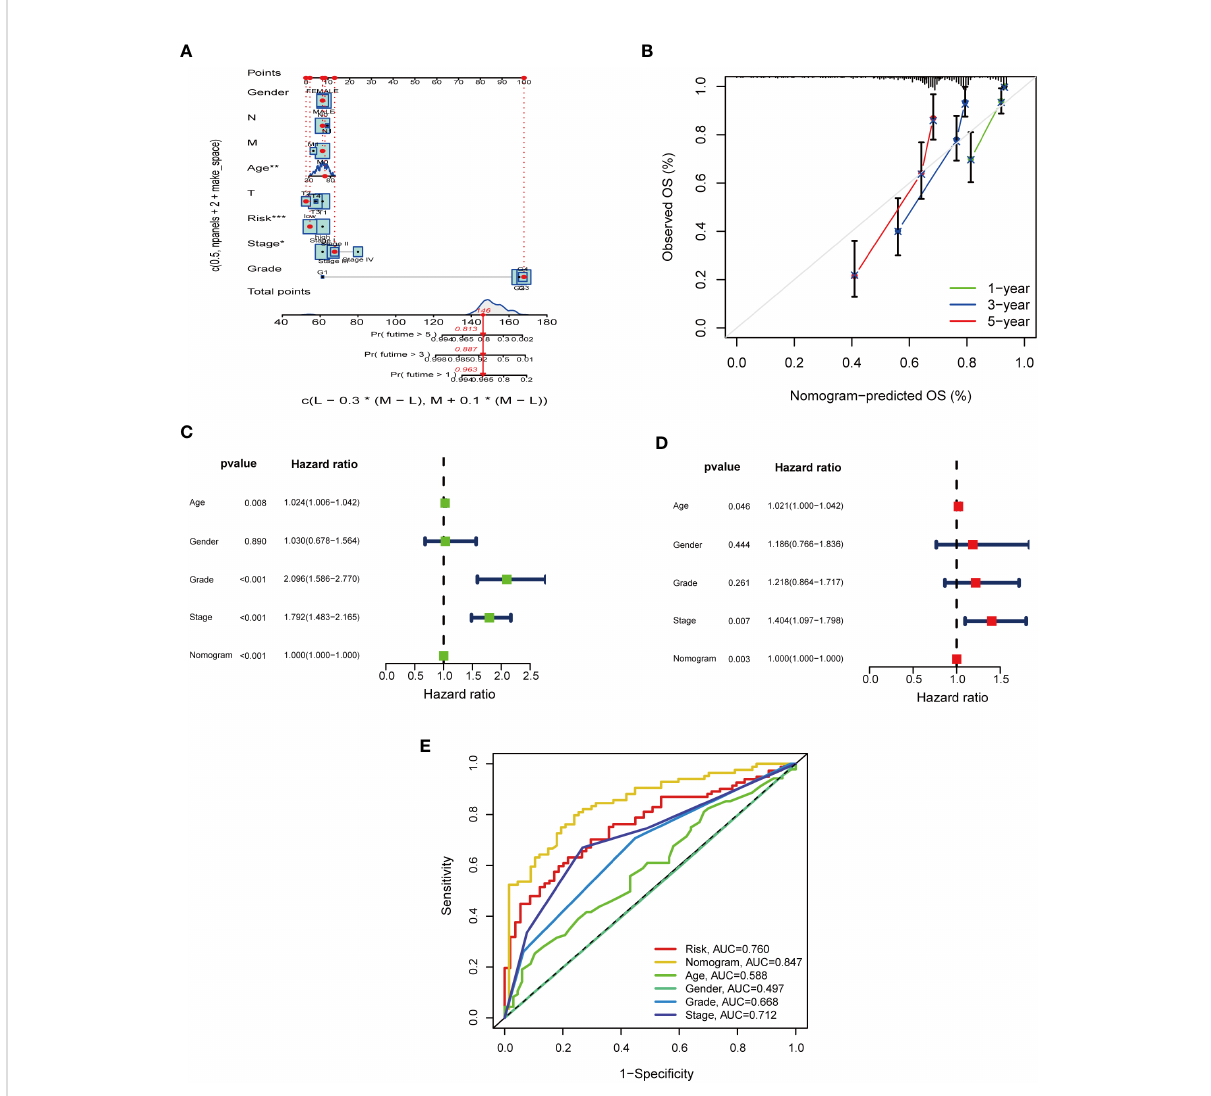
FIGURE 6 The predictive value of nomogram design and nomogram scores when combined with pathological features in the TCGA cohort. (A) Nomogram predicting 1-, 3-, and 5-year OS in the TCGA cohort. (B) The calibration curves for 1-, 3-, and 5-year OS. (C, D) . The multi-Cox-reg and uni-Cox-reg analyses of the nomogram and pathological features. (E) ROC curves for BM scores, nomogram, and pathological